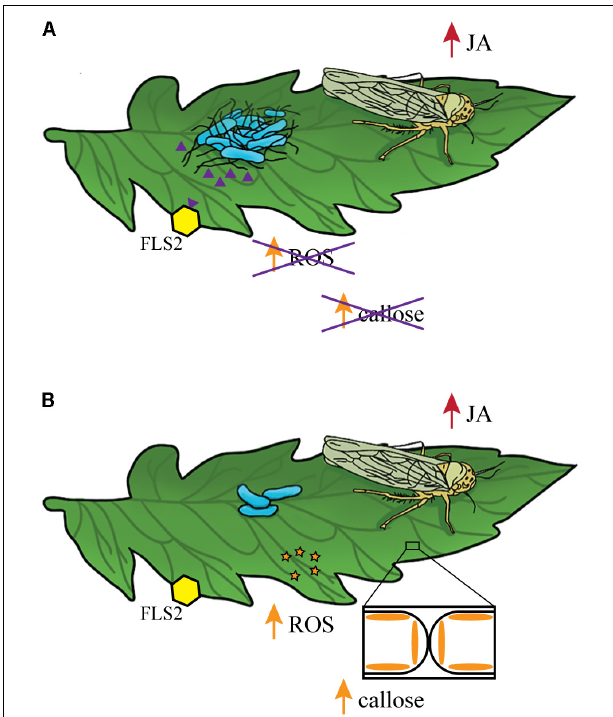
FIGURE 7 | Model describing the link between the bacterial flagellum and the positive effects of leafhopper infestation on S. Typhimurium persistence. (A) Leafhopper infestation leads to increased populations of flagellated S. Typhimurium (blue) on the leaf surface. Leafhopper-induction of the JA response (red) in combination with recognition of extracellular S. Typhimurium flg22 peptides (purple triangles) by FLS2 (yellow hexagon) inhibit ROS activation and callose deposition. (B) Although leafhoppers induce the JA response (red), non-flagellated S. Typhimurium populations (blue) decline due to activation of ROS activation (orange stars) and callose